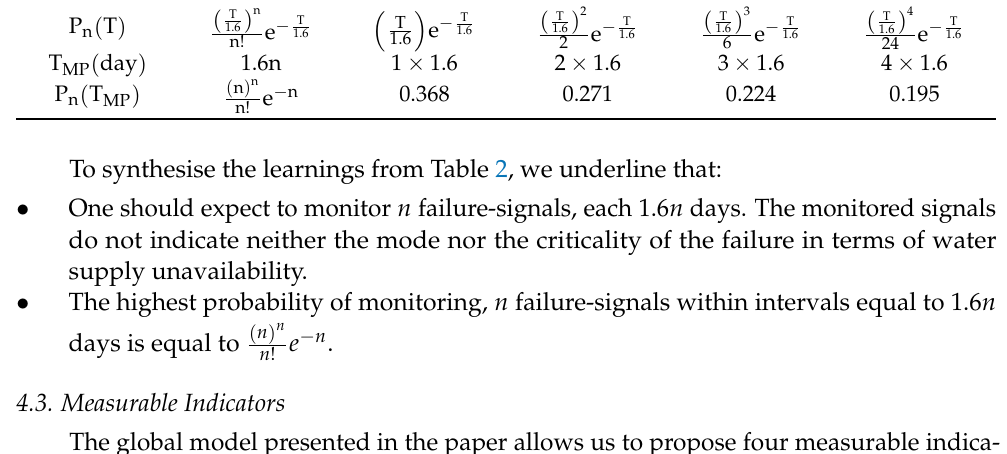
Table 3. The most probable intervals to observe n failure-occurrences in the WSS.